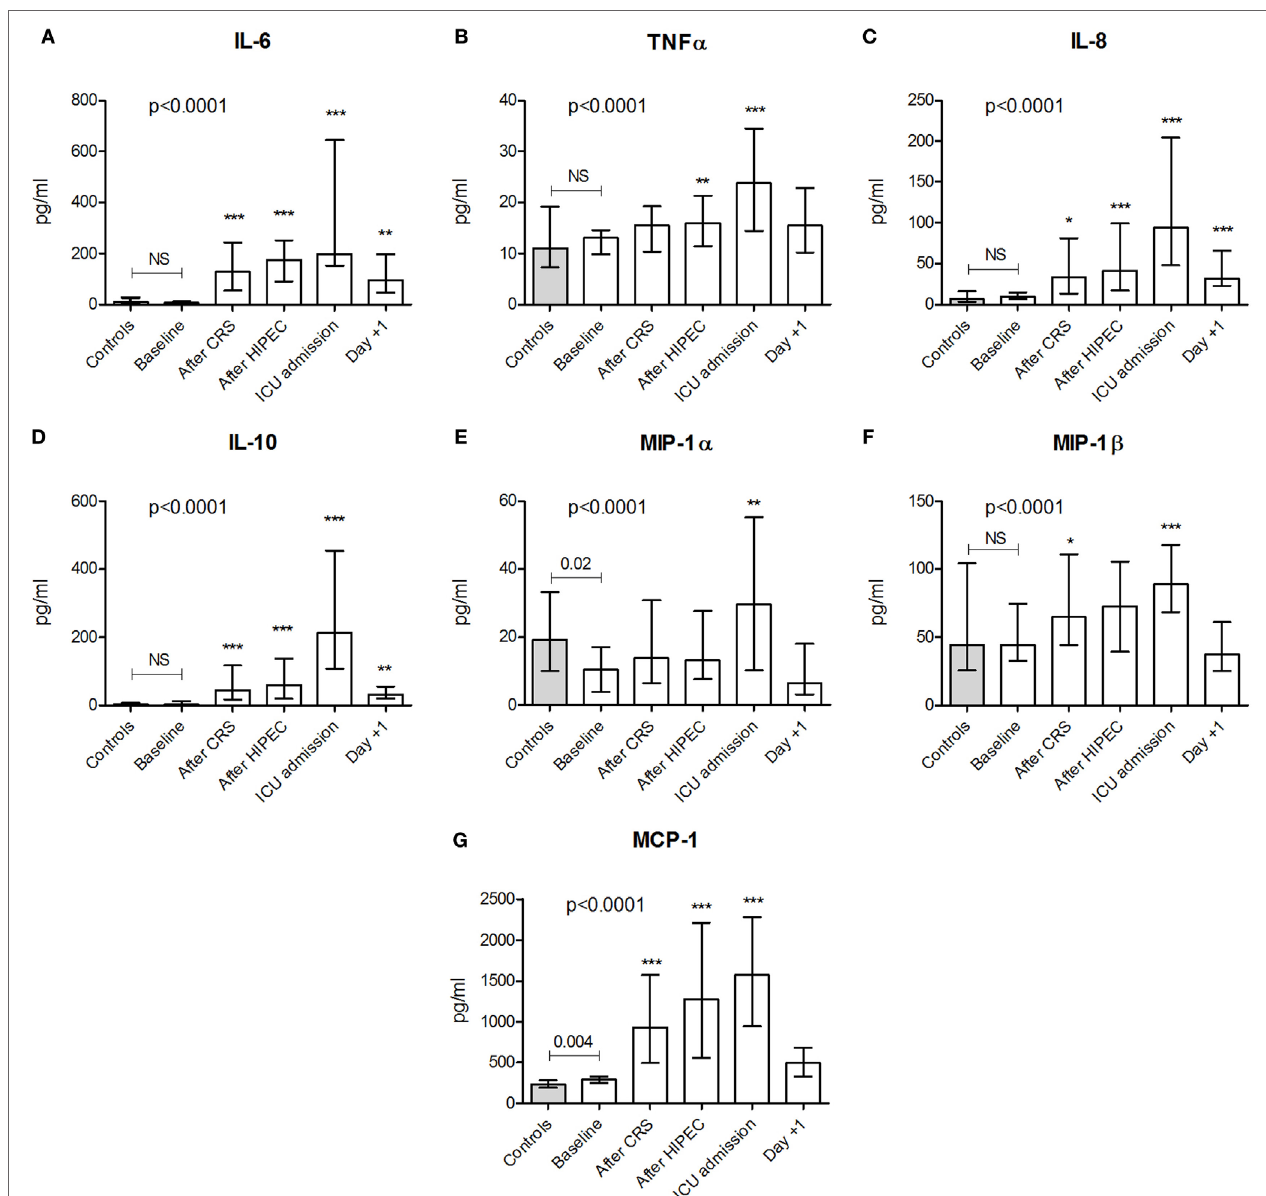
FigUre 3 | Plasma concentrations of cytokines. Plasma levels of (a) interleukin (IL)-6, (b) tumor necrosis factor α , (c) IL-8, (D) IL-10, (e) macrophage inflammatory protein